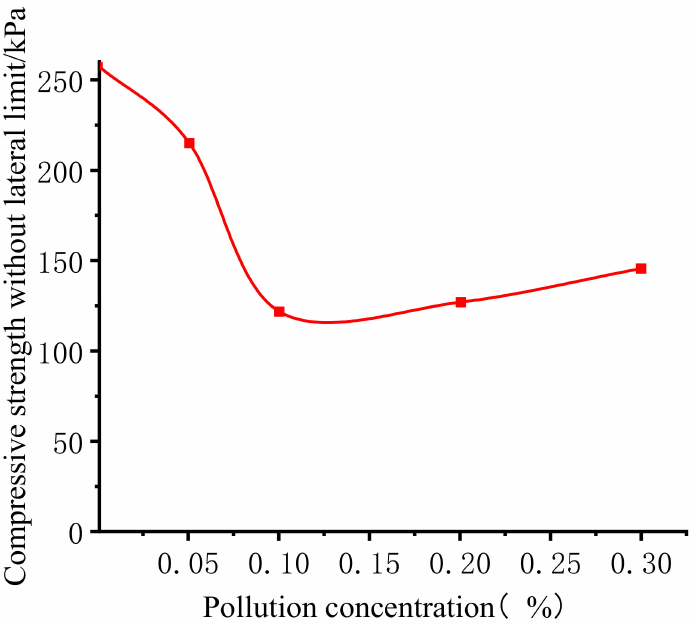
Figure 2. Relationship between different pollution concentrations and unconfined compressive strength.